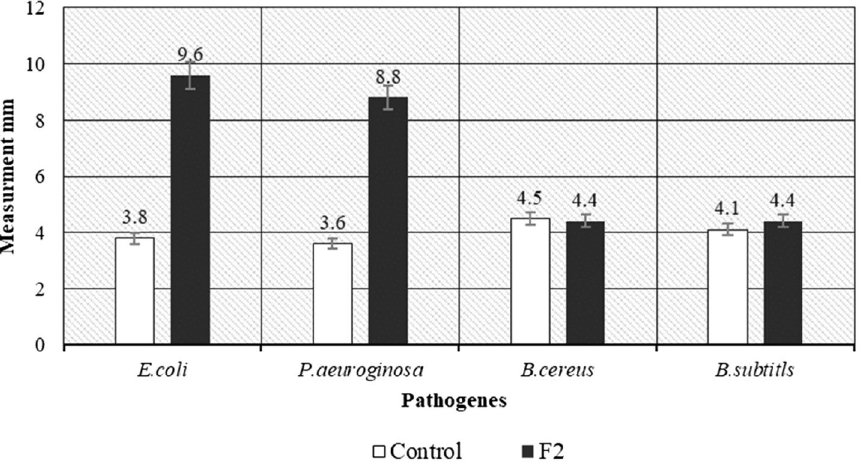
Figure 4. Antibacterial activity of F2 using disk diffusion method.